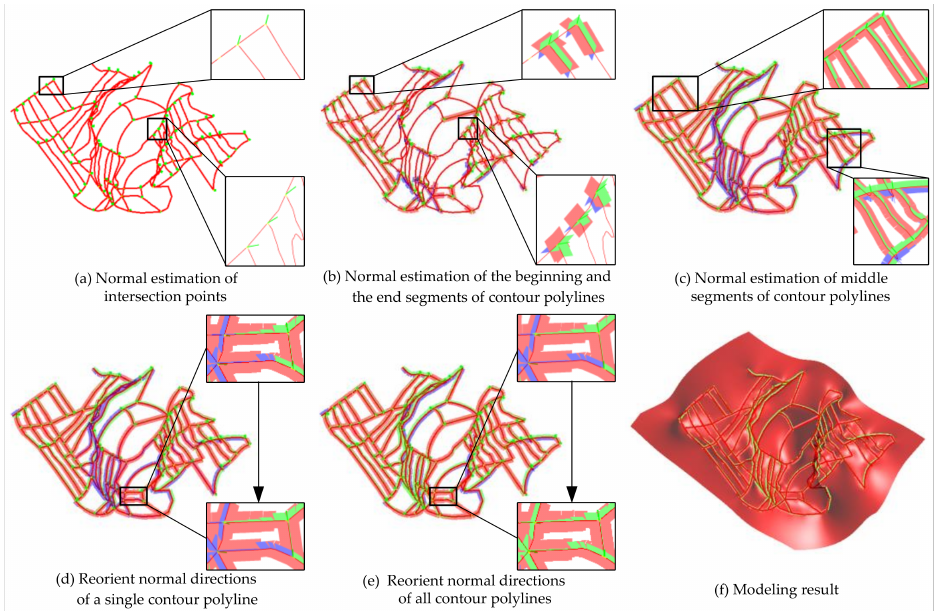
Figure 10. Experimental results of the second set of cross-contour polylines. ( a – c ) show the process of the normal estimation; ( d , e ) show the process of the reorientation of normal directions; ( f ) shows the final modeling result.